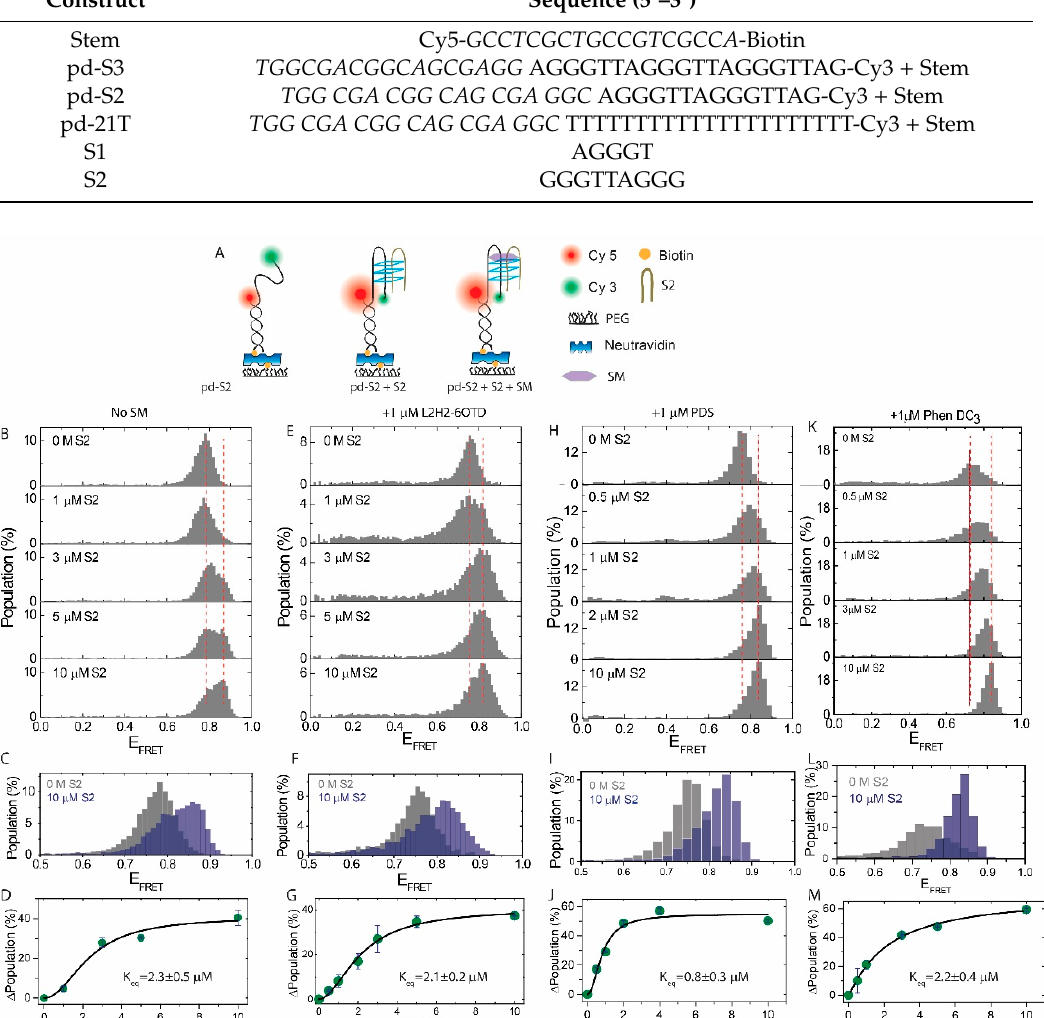
Table 1. DNA sequences used for this study. The sequences that formed the stem are shown in bold fonts. Stem is complementary to an 18nt segment in the pd-S3, pd-S2, and pd-21T. Construct